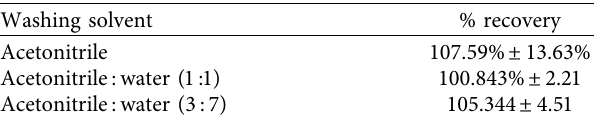
Table 4: % recovery salbutamol using diferent washing solvents.